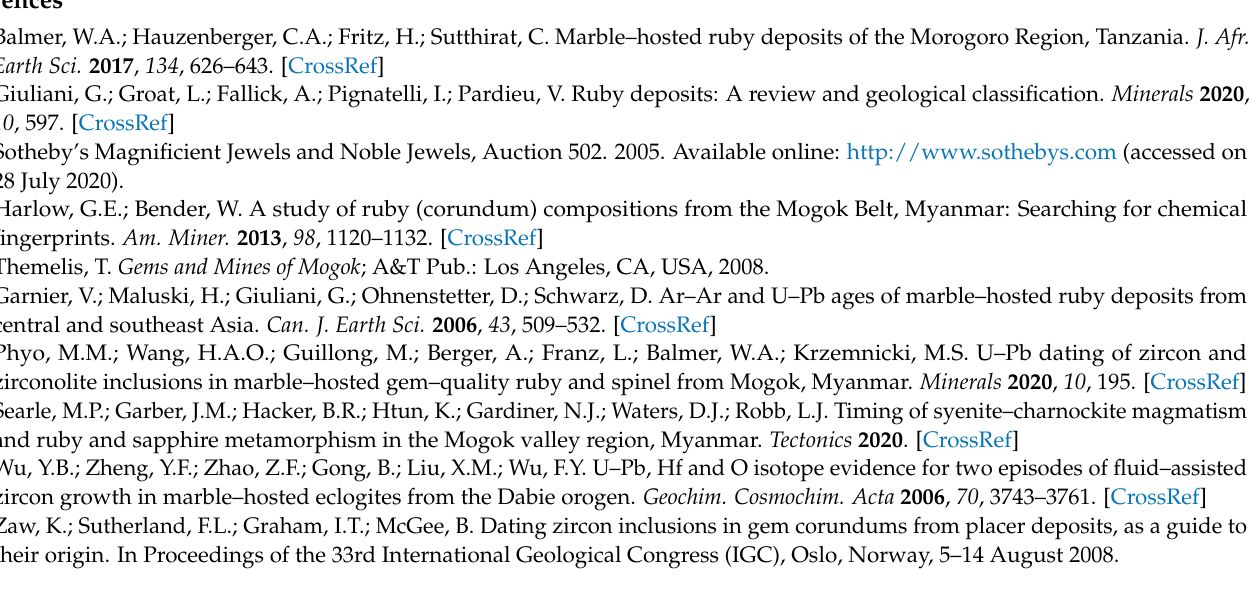
Table S6: Representative trace elements compositions of titanite in studied samples ( µ